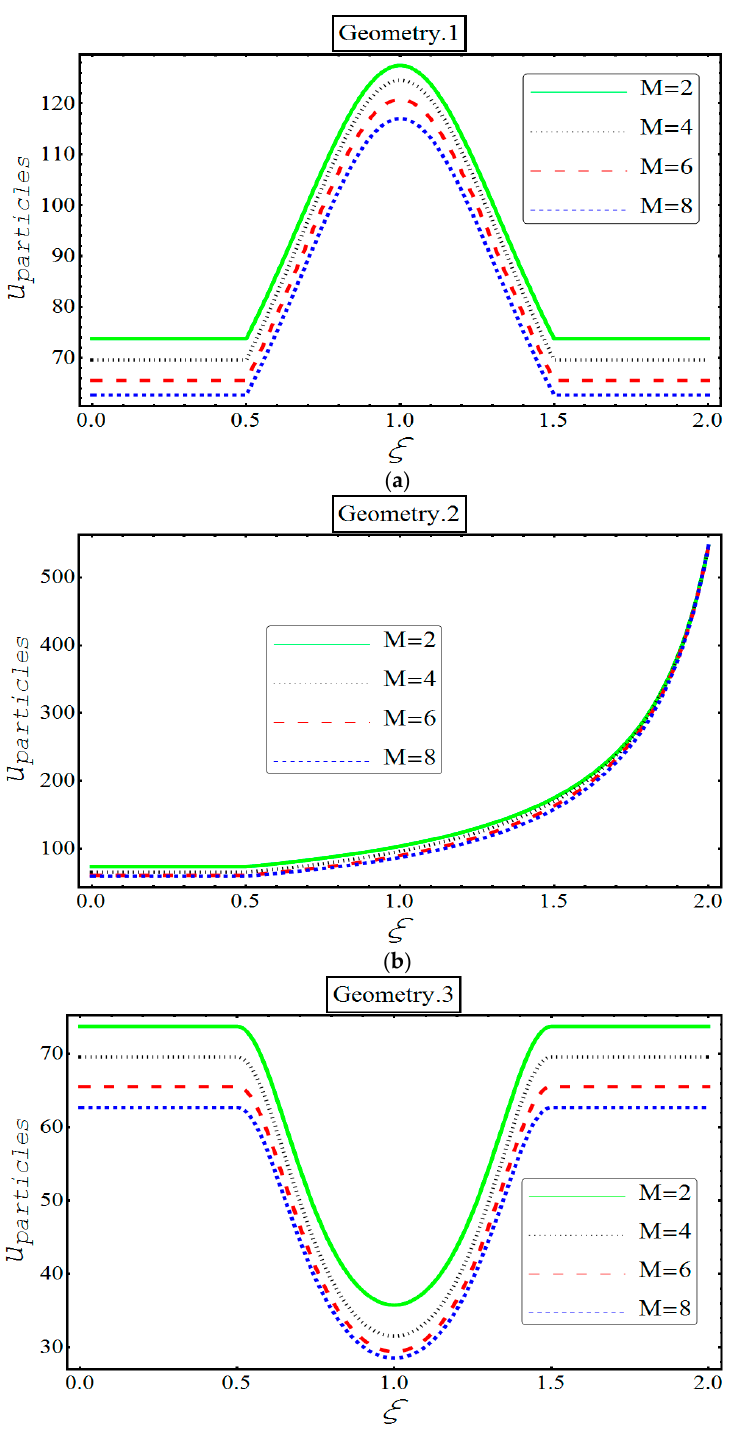
Figure 5. Variation of velocity (cid:1873) (cid:3043) for various Hartmann numbers.